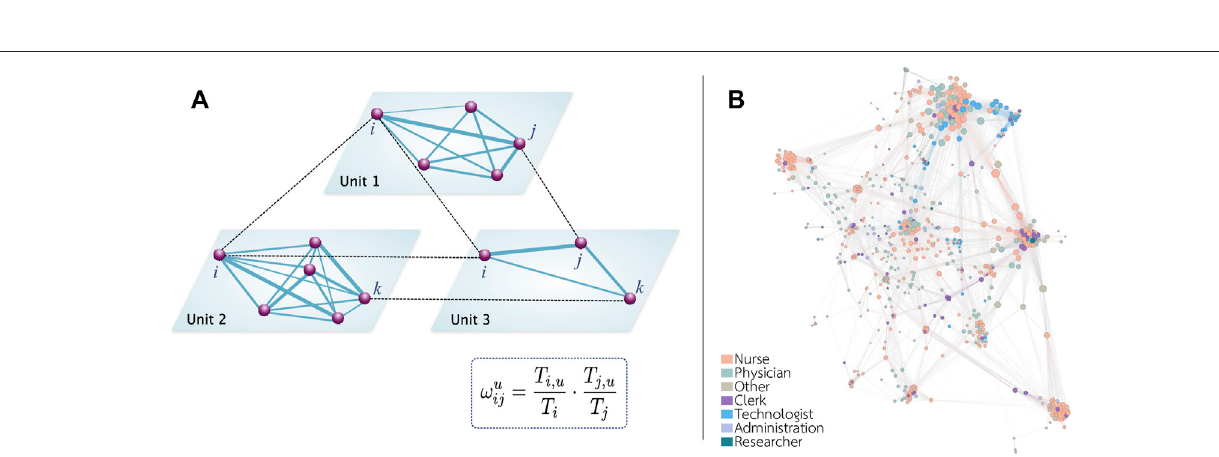
Frontiers in Physics |